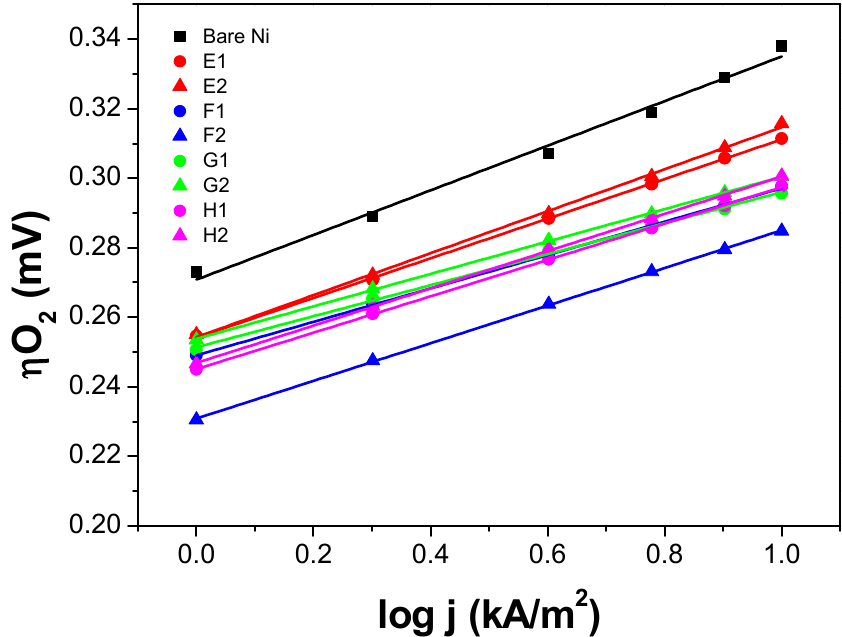
Figure 6. Electrochemical oxygen evolution reaction (OER) polarization curves of the IrO 2 thin film electrodes (Tafel plots). Number after the letter corresponds to the pre-treatment of the Ni expanded mesh substrates: 1—sandblasted and acid etched; 2—not sandblasted but acid etched. The symbol (cid:4) corresponds to the bare/uncoated Ni expanded mesh.